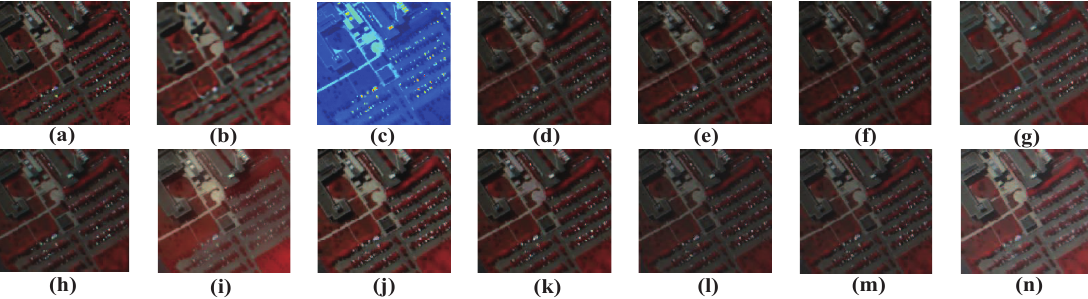
Figure 9. Visual results obtained by different methods on the University of Pavia data set: ( a ) ground truth, ( b ) up-sampled HSI, ( c ) PAN, ( d ) SFIM, ( e ) MTF-GLP, ( f ) MTF-GLP-HPM, ( g ) GS, ( h ) GSA, ( i ) GFPCA, ( j ) CNMF, ( k ) Lanaras’s, ( l ) FUSE, ( m ) HySure, ( n ) SCAAE. Note that the false color image is chosen for clear visualization (red: 20, green: 40, and blue: